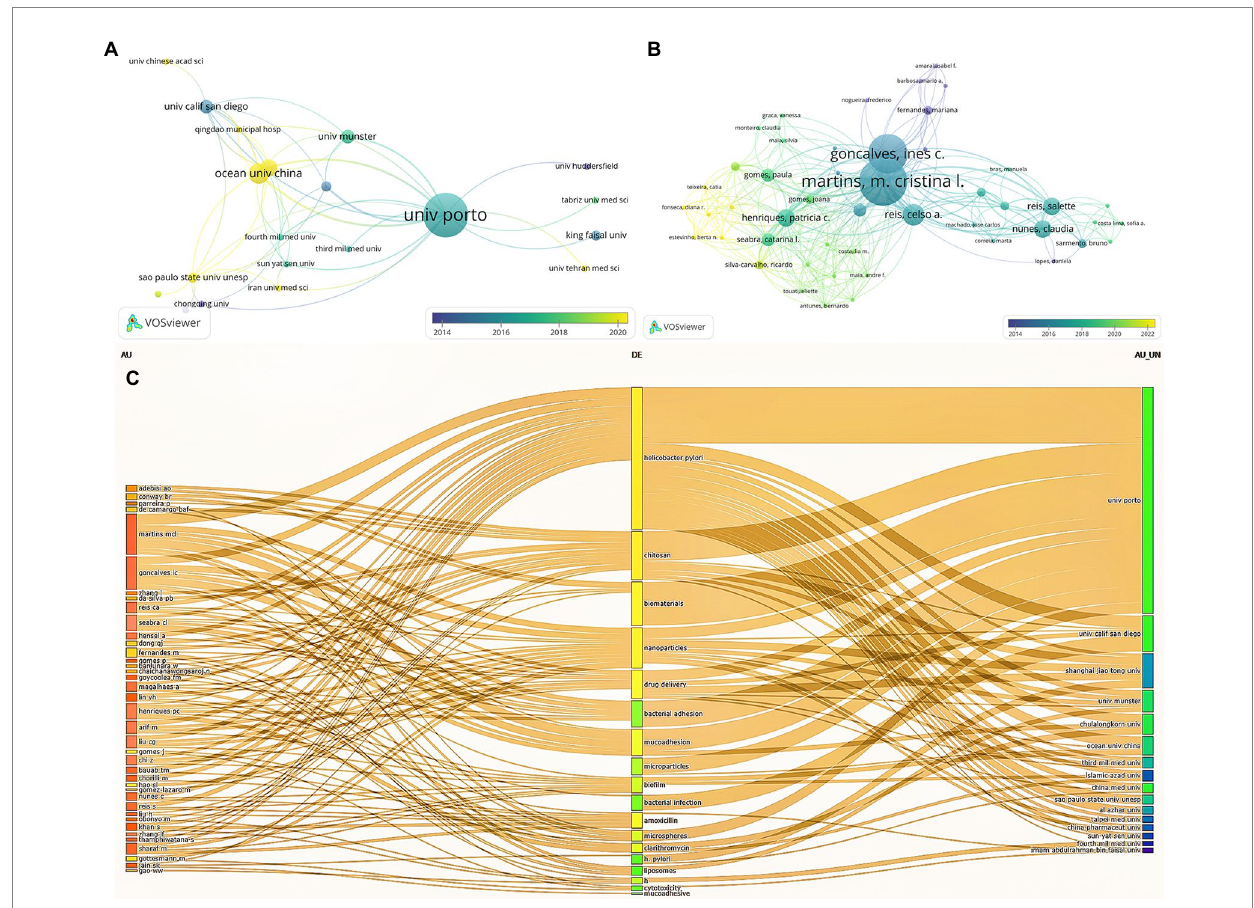
FIGURE 4 Cited institution (A) , author cooperation analysis (B) , and Three-Field Plot of author, keyword, and institution (C) . Each node represents an institution or an author, and the line between the two nodes indicates that they have a co-occurrence relationship. Moreover, the closer the distance, the stronger the relationship (A,B) . In (C) , the leftmost square represents the author, the middle is the keyword, and the rightmost is the institution and longer squares mean more